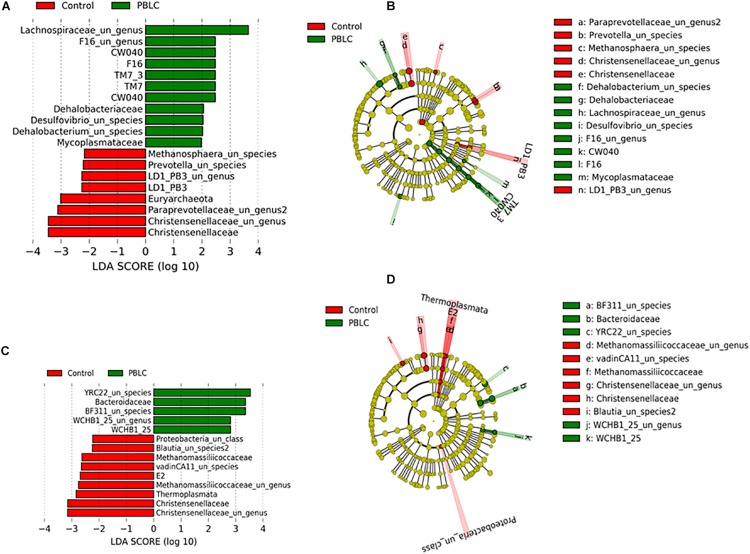
Linear discriminant analysis effect size (LEfSe) and their cladograms of biomarker genera and species in the solid (A,B) or liquid (C,D) fractions of the rumen digesta. Nodes represent position of microbiota in taxa with circular and axial lines indicate the level of taxa and number of taxa at the lower level. Control and PBLC, sheep supplemented with 0 and 80 or 160 mg/d menthol-rich plant bioactive lipid compounds.